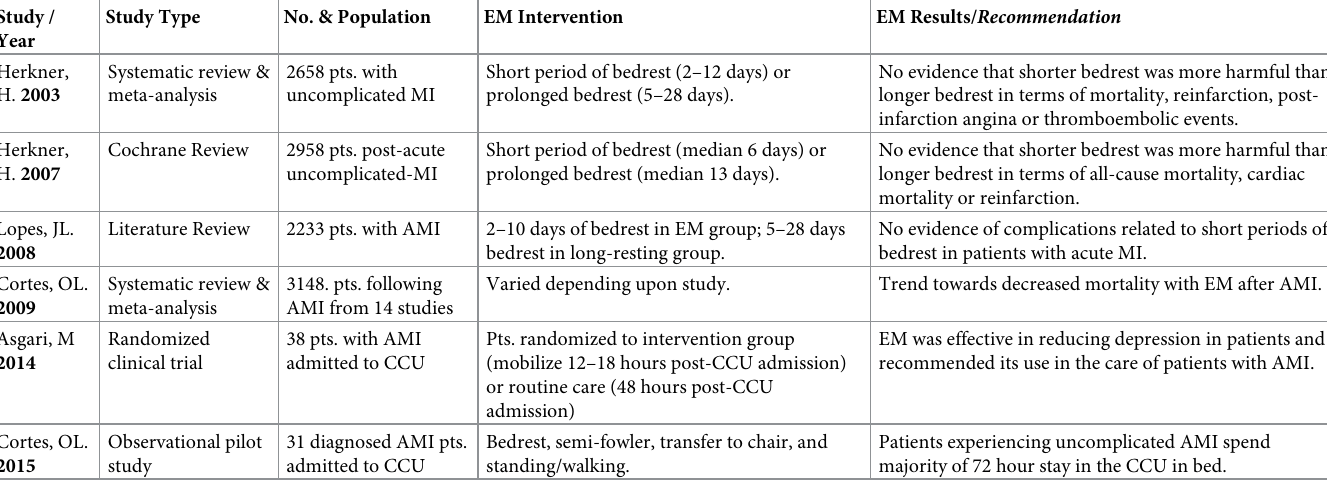
Table 1. Modern early mobilization practices post-myocardial infarction.